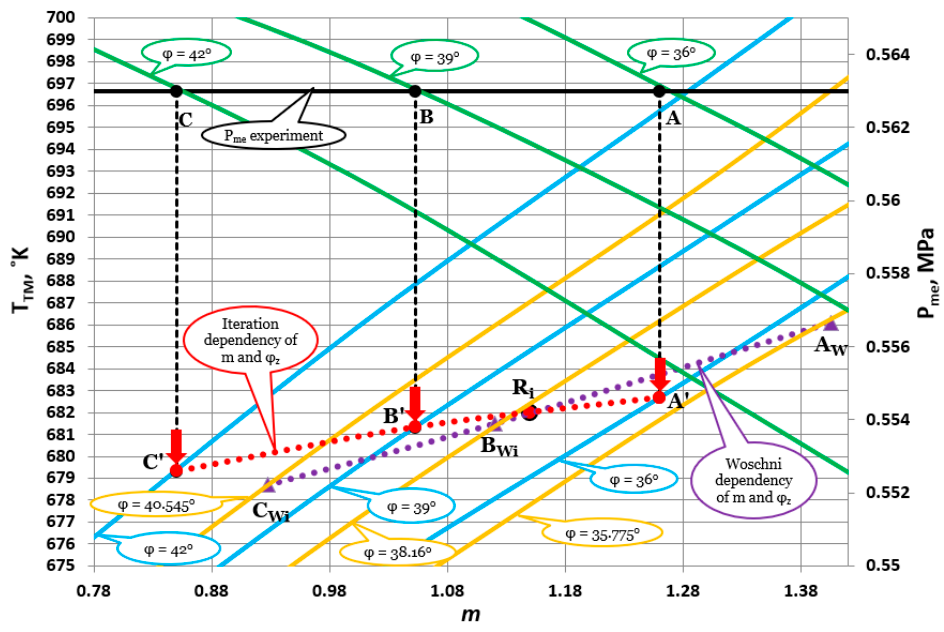
Figure 7. Graphical expression of iteration method for 1.9 TDI diesel engine at ‘0’ load